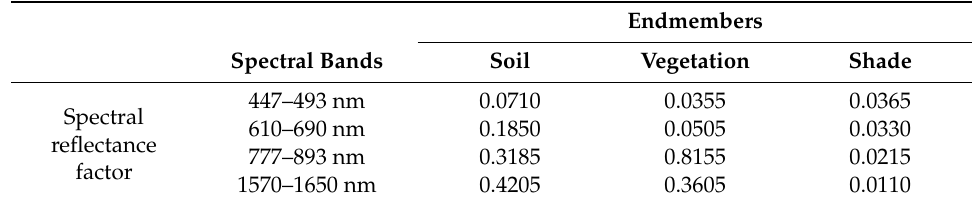
Table 1. Spectral reflectance values for the three endmembers extracted from the median image mosaic described previously.